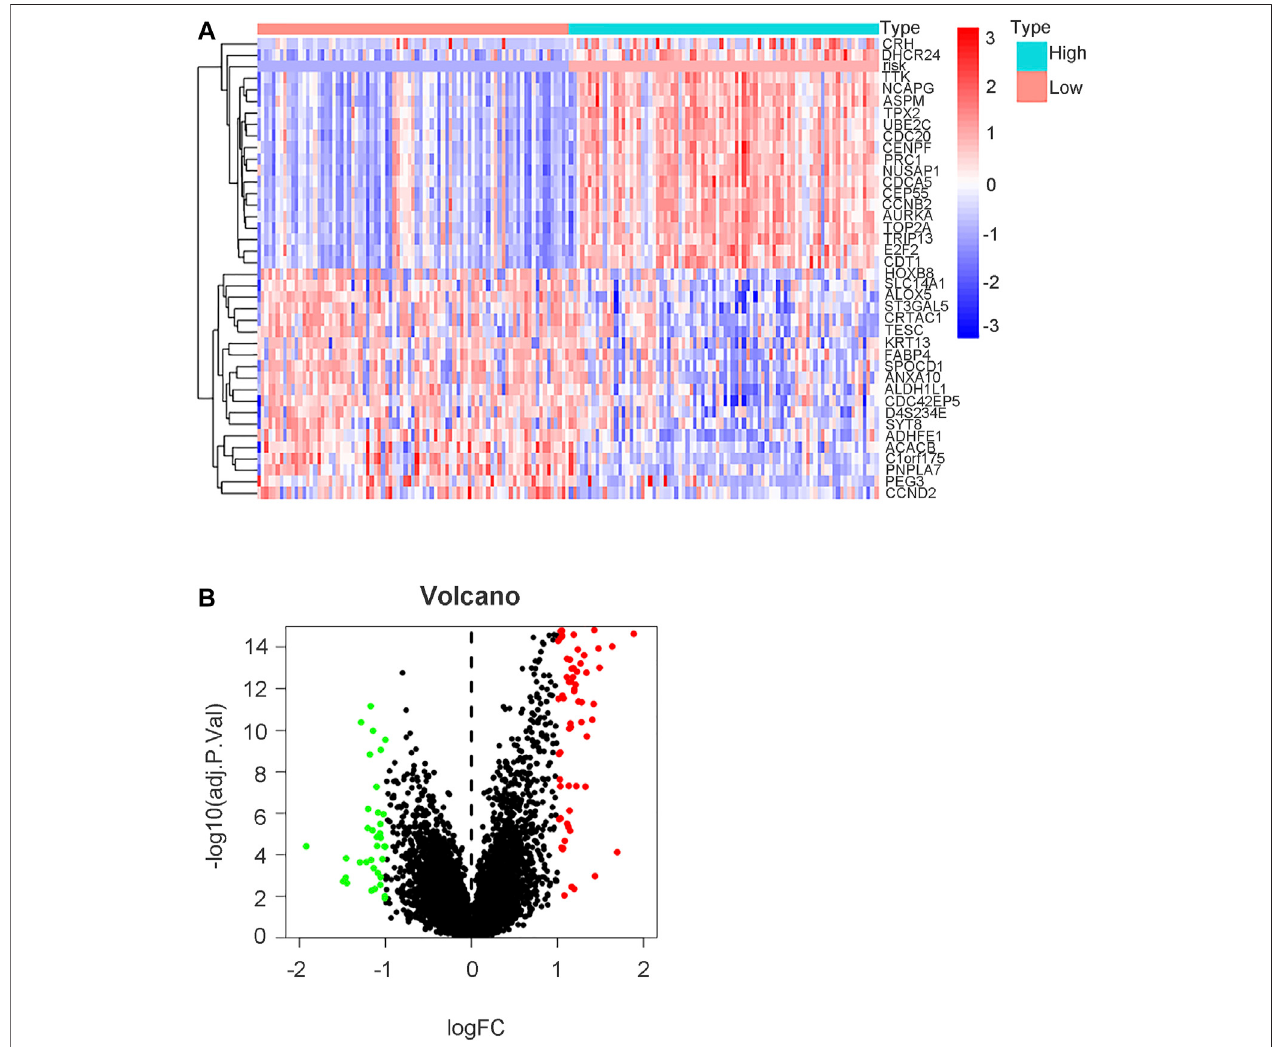
FIGURE 9 | DEGs analysis between high risk group and low risk group in GEO cohort. (A) Gene heatmap showing distribution of DEGs between high risk group andlowriskgroupinGEOcohort.Theterm “ risk ” indicatedourrisksignatureandothertermsindicatedDEGsinouranalysis. (B) VolcanomapofDEGsbetweenhighrisk group and low risk group (|logFC| > 1, P. adjust <